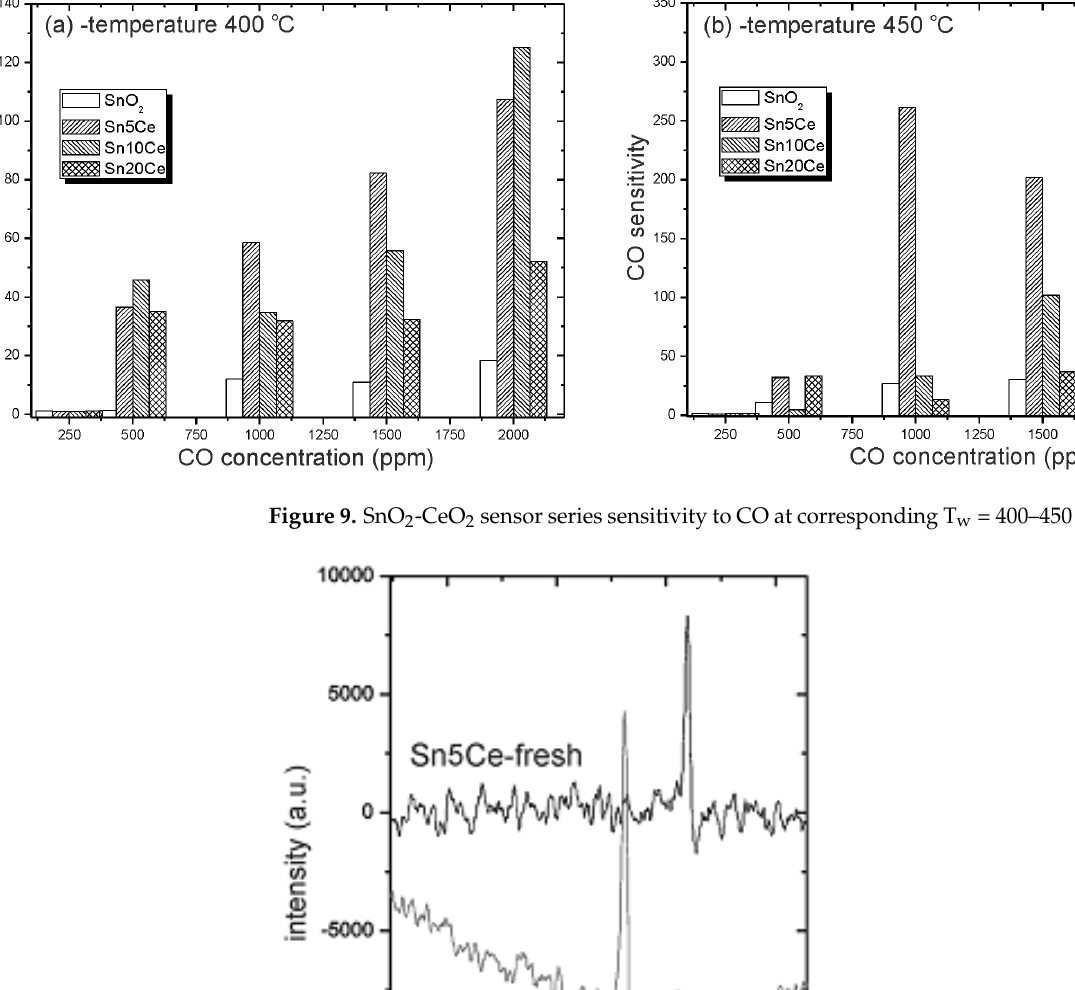
Figure 8. 5% SnO 2 -CeO sensor response/recovery characteristics at T w = 400 °C, from ref. [40].